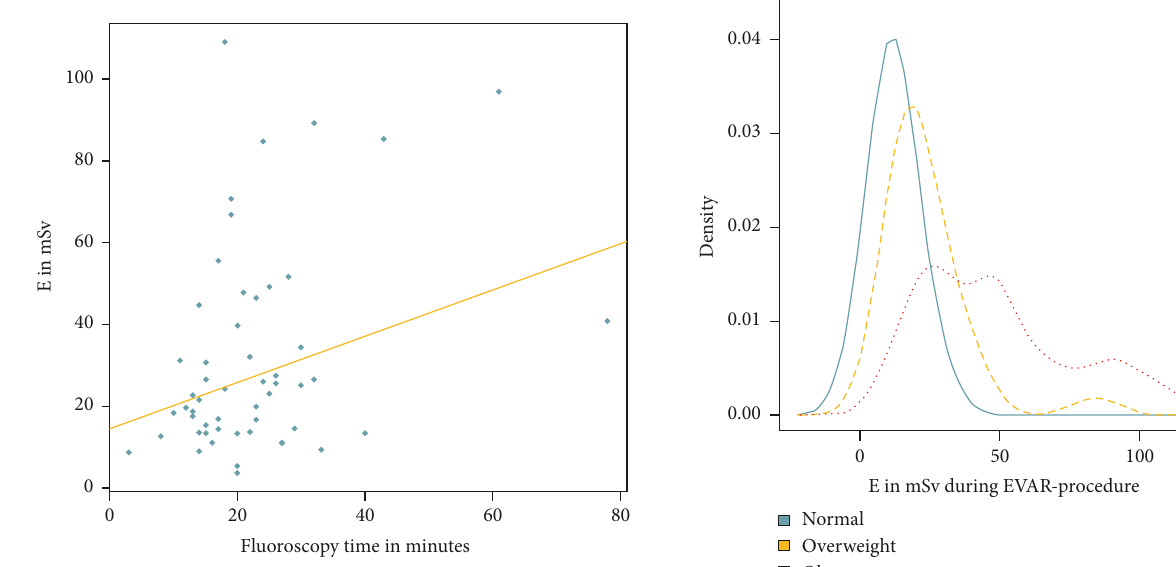
Figure 4: Correlation between fluoroscopy time [in minutes] and ED [in mSv] from the EVAR procedure.